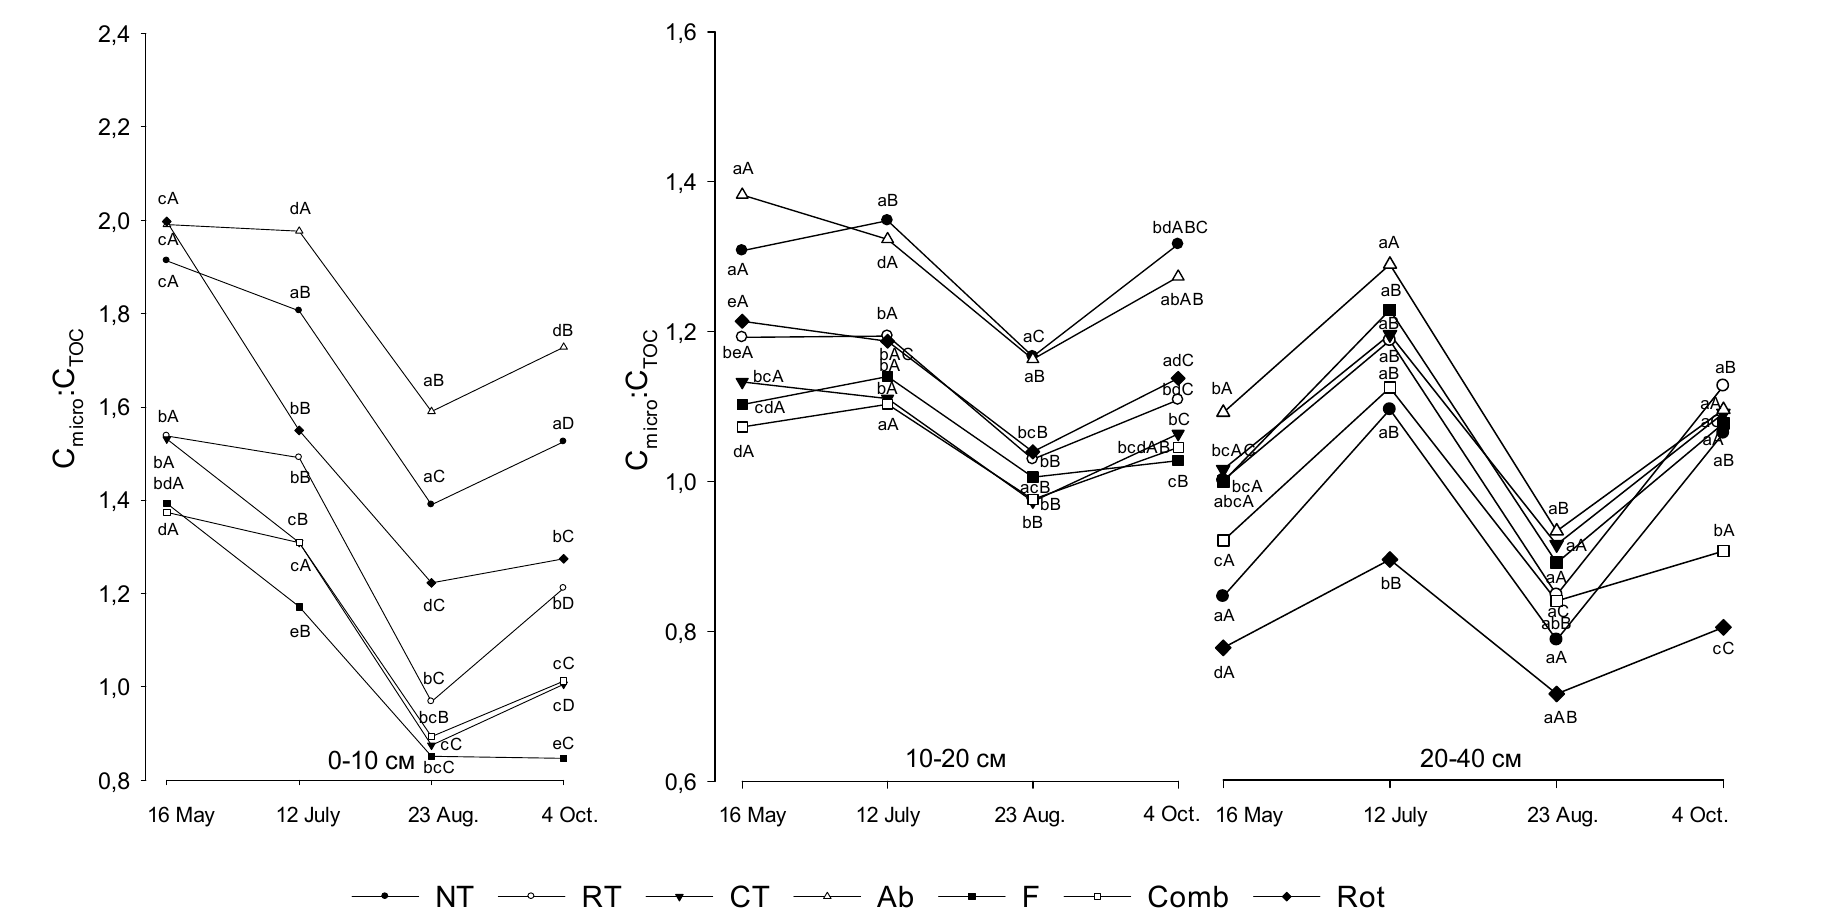
Figure 8. MI dynamics in different layers of Mollisol after 9 years of use: conservation tillage (CT), no till (NT), rotary (Rot), reduced (ridge) tillage (RT), combined (Comb) tillage, fallow (F, 22 years) and abandoned field (Ab, 22 years). Average values with different lowercase letters indicate a significant difference between tillage options, and uppercase letters are a significant difference between the selection periods ( НІР , α = 0.05).